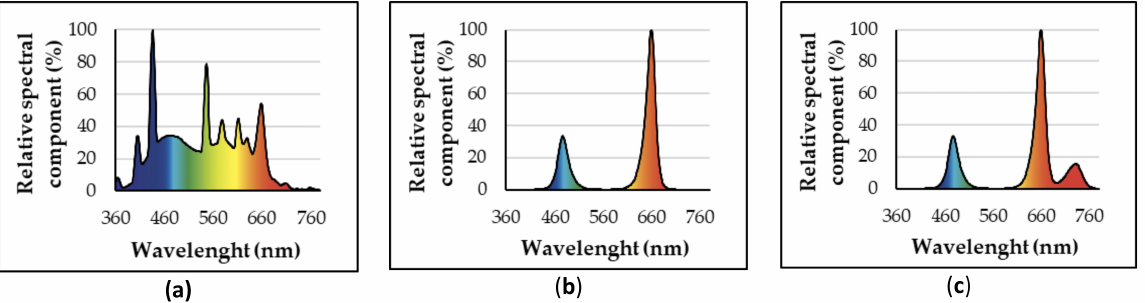
Figure 1. Spectral composition of the light supplied by FL ( a ), RB ( b ) and RB+FR ( c ) treatments used during the